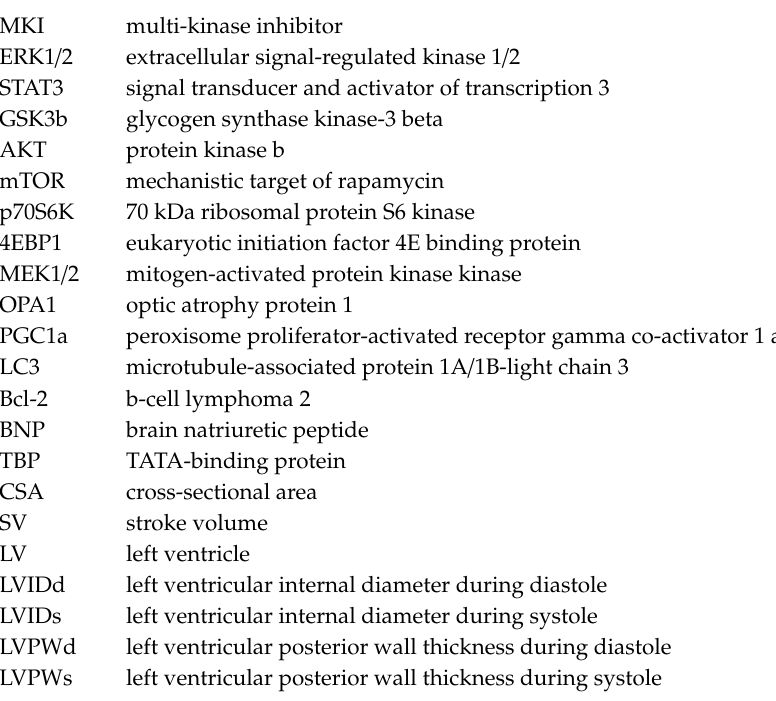
Figure S1: Food consumption is not a ff ected by regorafenib or sorafenib, Figure S2: BNP mRNA expression is increased in animals treated with